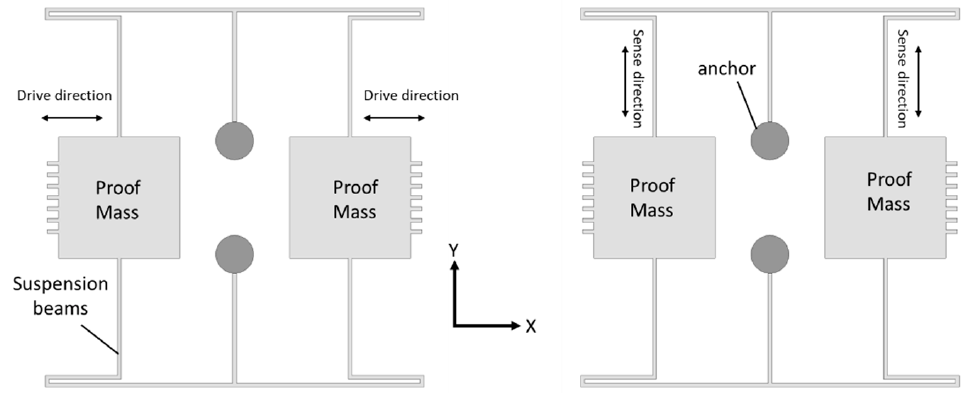
Figure 9. Working operation of a basic MEMS tuning fork gyroscope.